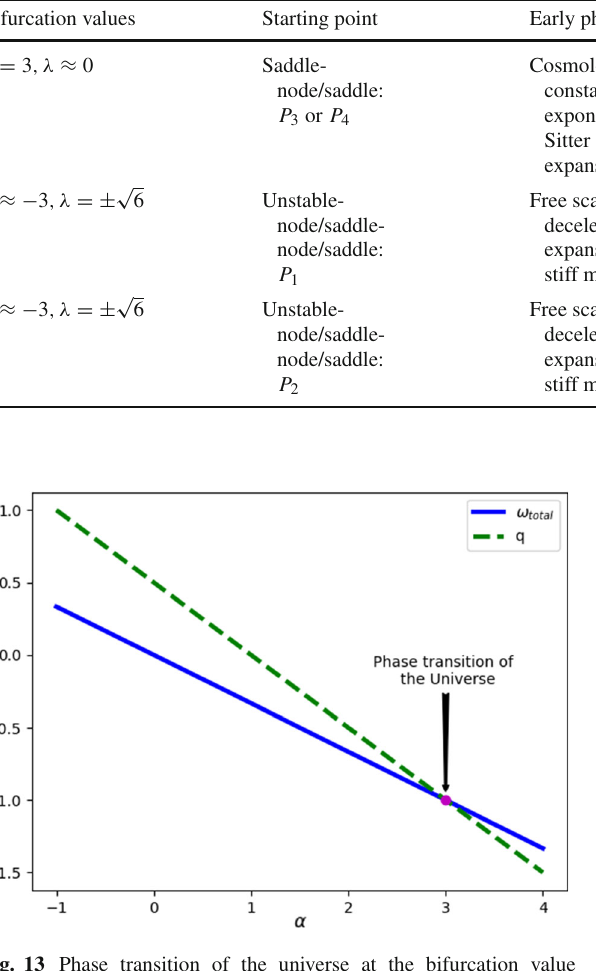
Fig. 13 Phase transition of the universe at the bifurcation value α = 3